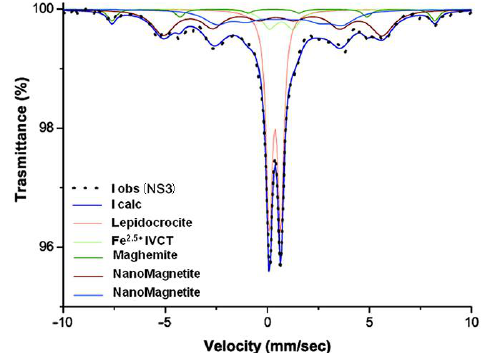
Figure 10. Mössbauer spectra of the historical marble NS3. Observed absorption intensity (I obs, black dots) and calculated total intensity (I calc, continuous blue line) are plotted together with calculated absorption components (see text). Table 3. 57 Fe Mössbauer parameters relative to the studied archeological and artificially stained marble samples.